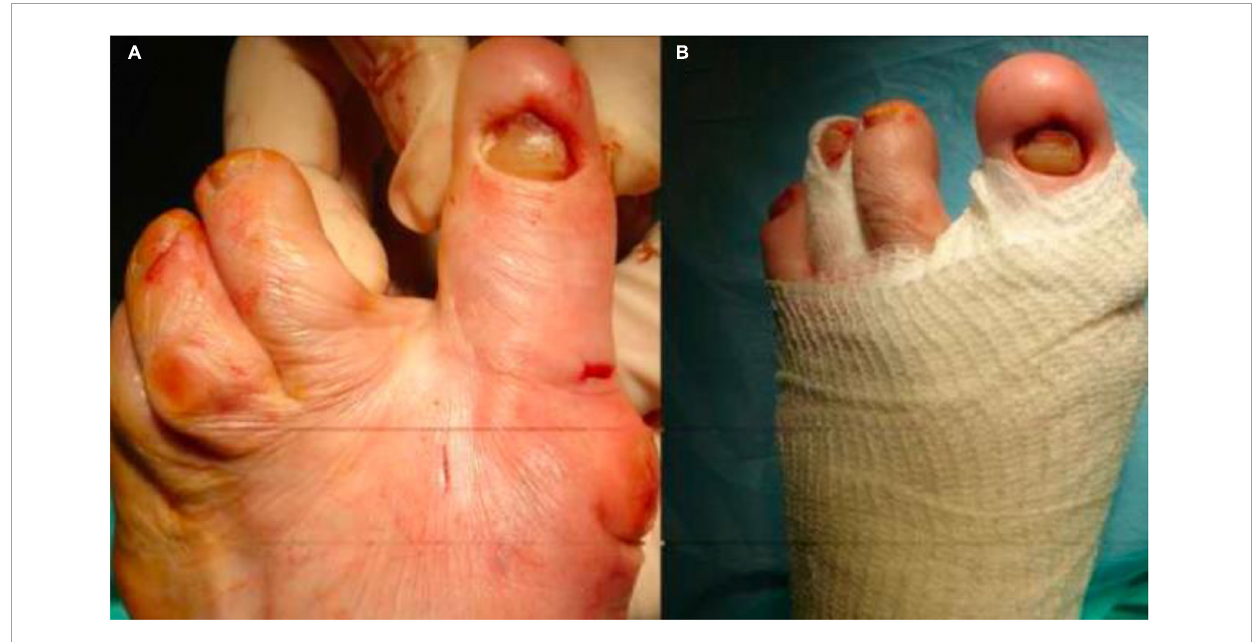
FIGURE7 Alignment (A) and bandaging of the first digit-metatarsal segment (B) .